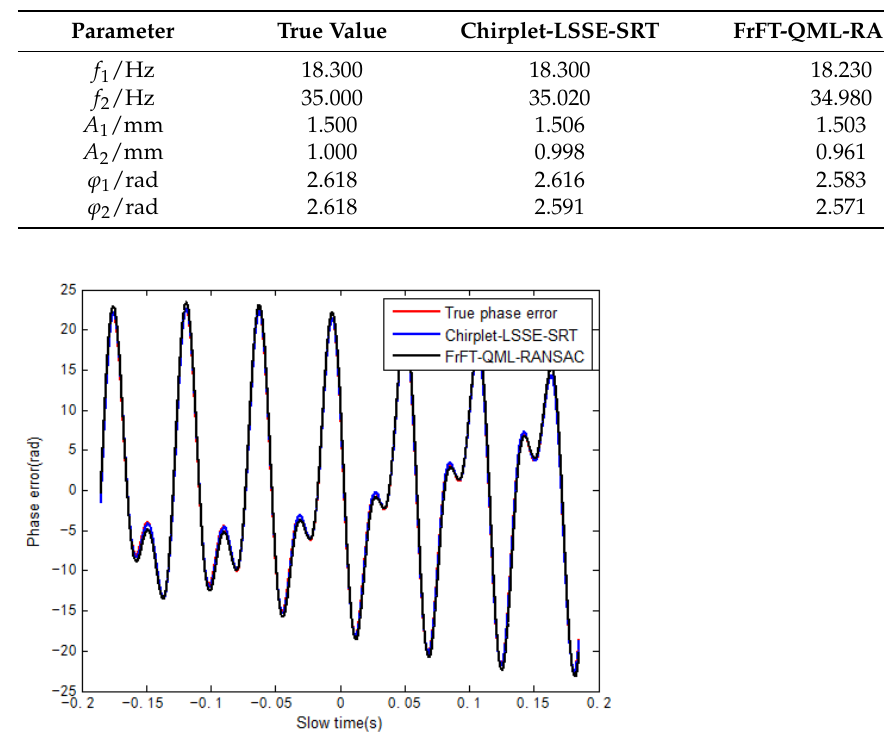
Figure 13. Estimate of phase errors of the distributed imaging scene.